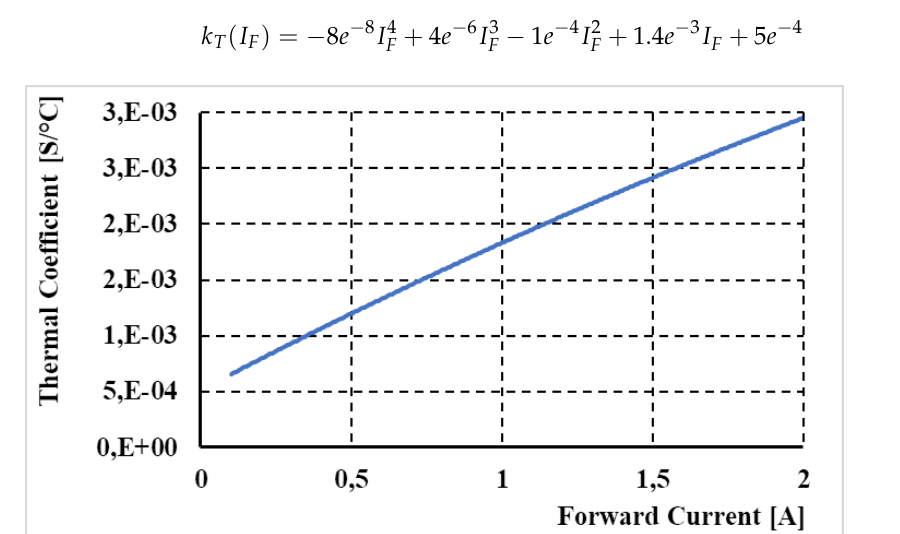
Figure 8. Thermal coefficient dependency on the diode forward current.